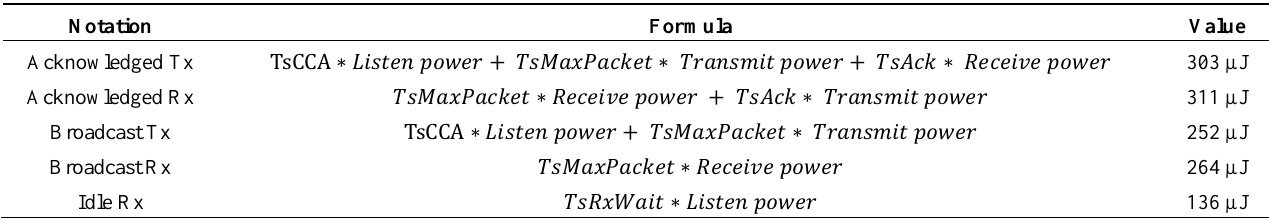
Table 6. Energy-consumption per transaction and its formula.